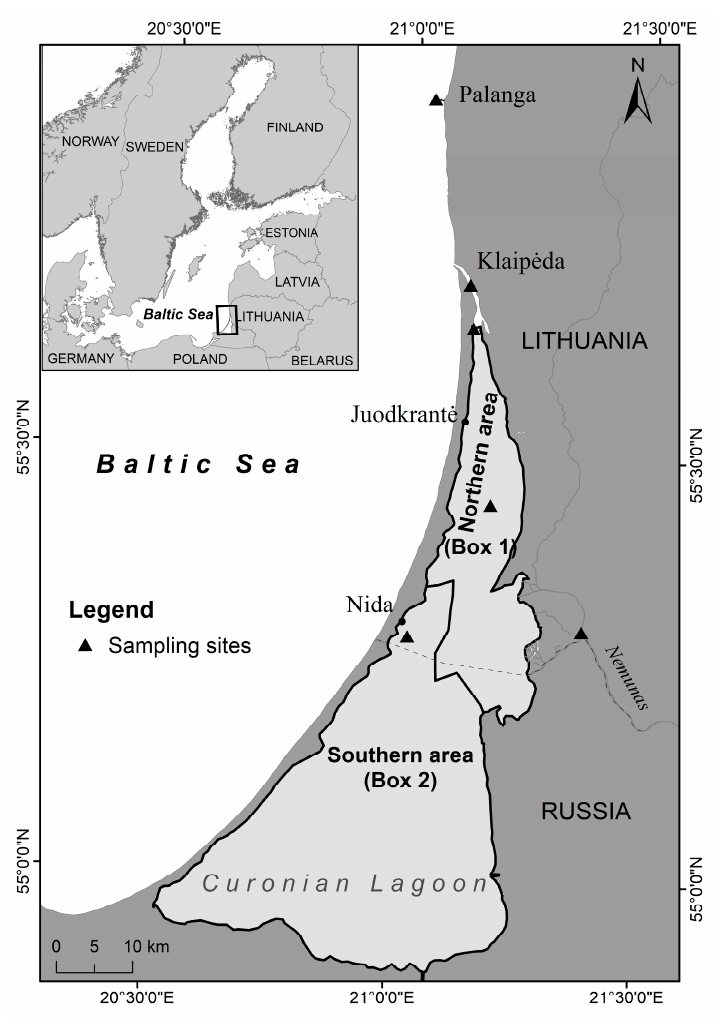
Figure 1. Map of the Curonian Lagoon reporting the sampling stations (black triangles) and the two boxes in which the system was divided for budget calculations.